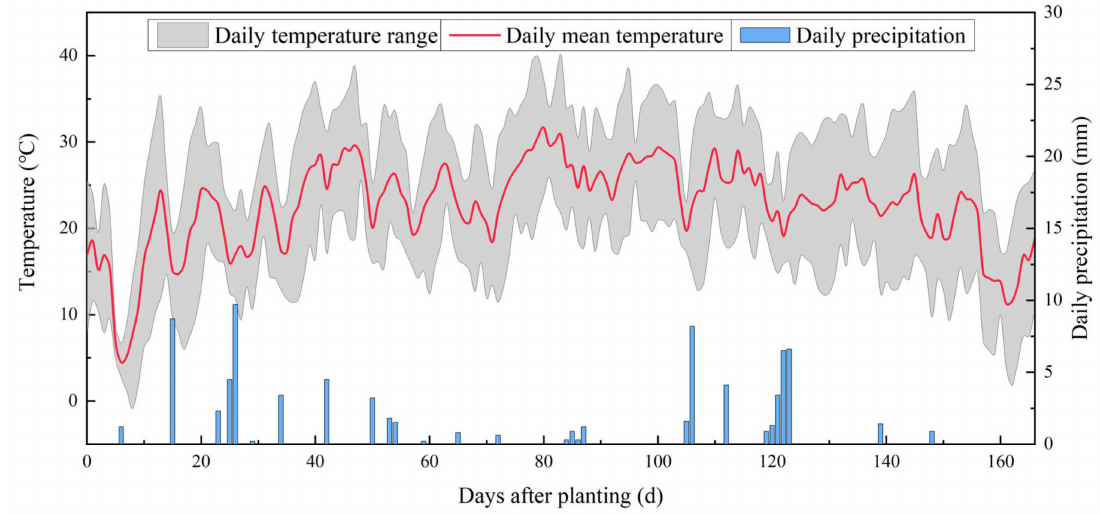
Figure 1. Daily air temperature and precipitation during the cotton growth period (from 17 April 2021 to 1 October 2021).